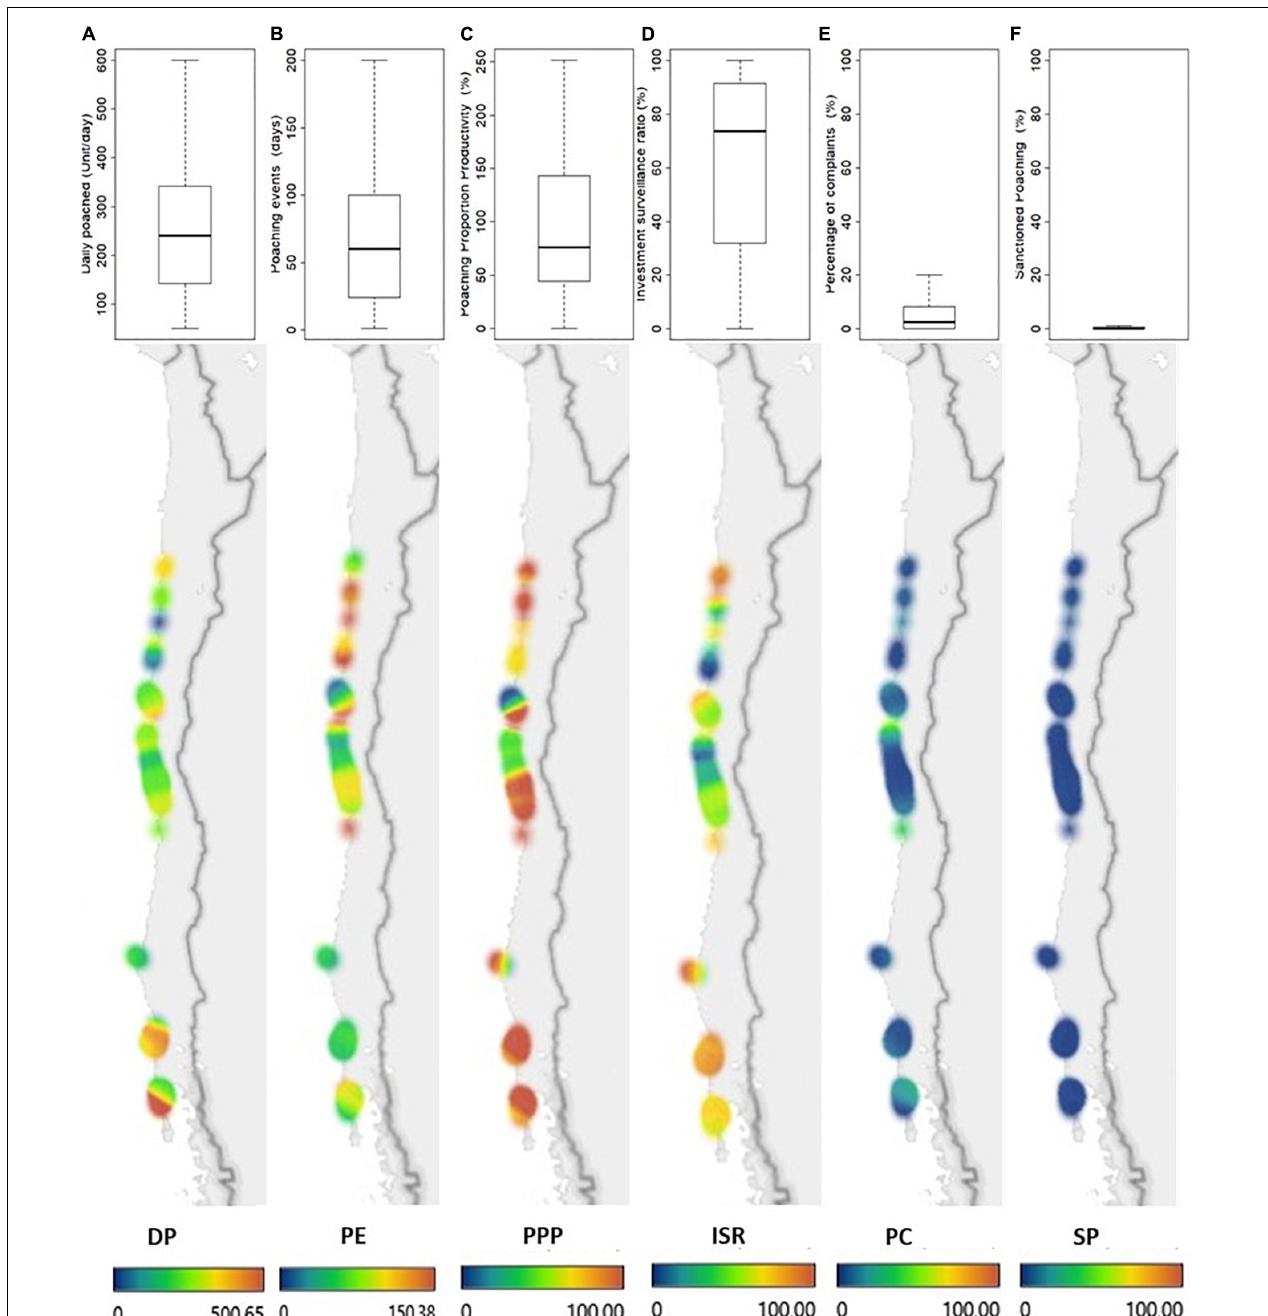
FIGURE 2 | Geographical comparison of indicators related to poaching: (A) daily poached (DP); (B) poaching events (PE); (C) poaching proportion of total quota (PPP); (D) investment in surveillance ratio (ISR); (E) percentage of complaints to the authorities (PC); and (F) sanctioned poaching events (SP), period 2017–2018.